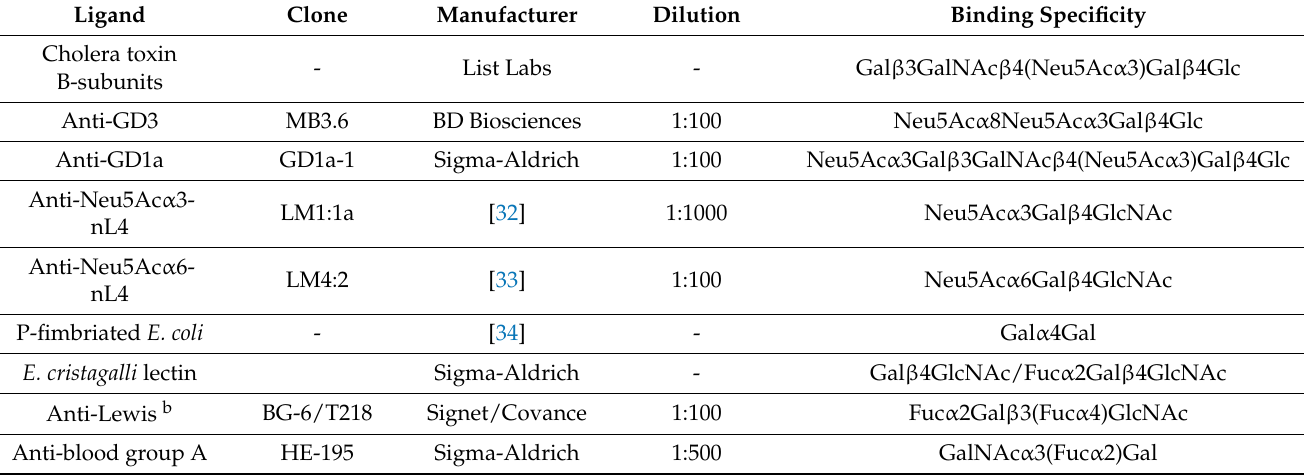
Table 4. Carbohydrate binding ligands used in chromatogram binding